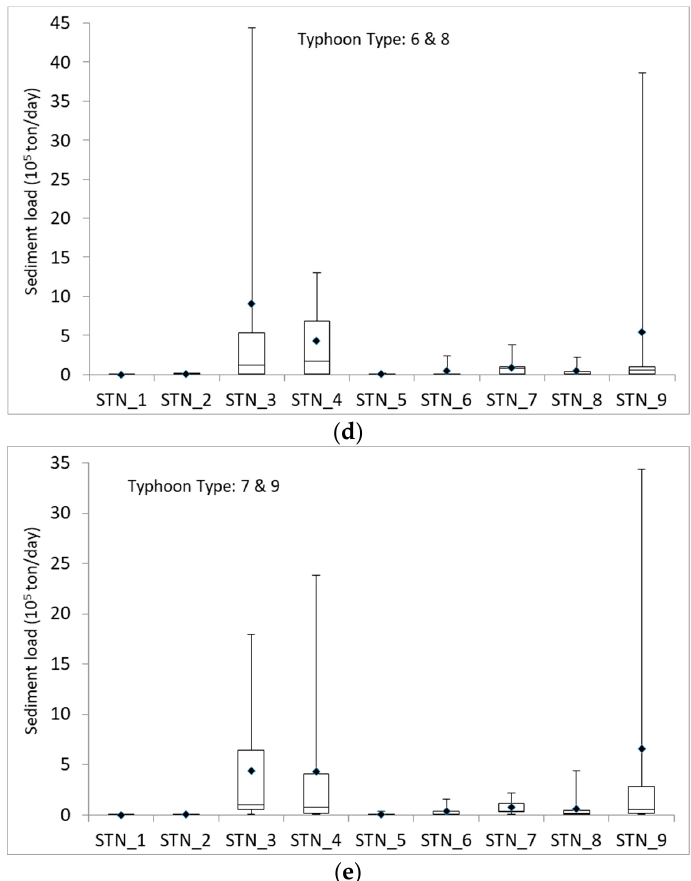
Figure 8. Average daily sediment load at nine gauging stations during typhoons of various types.